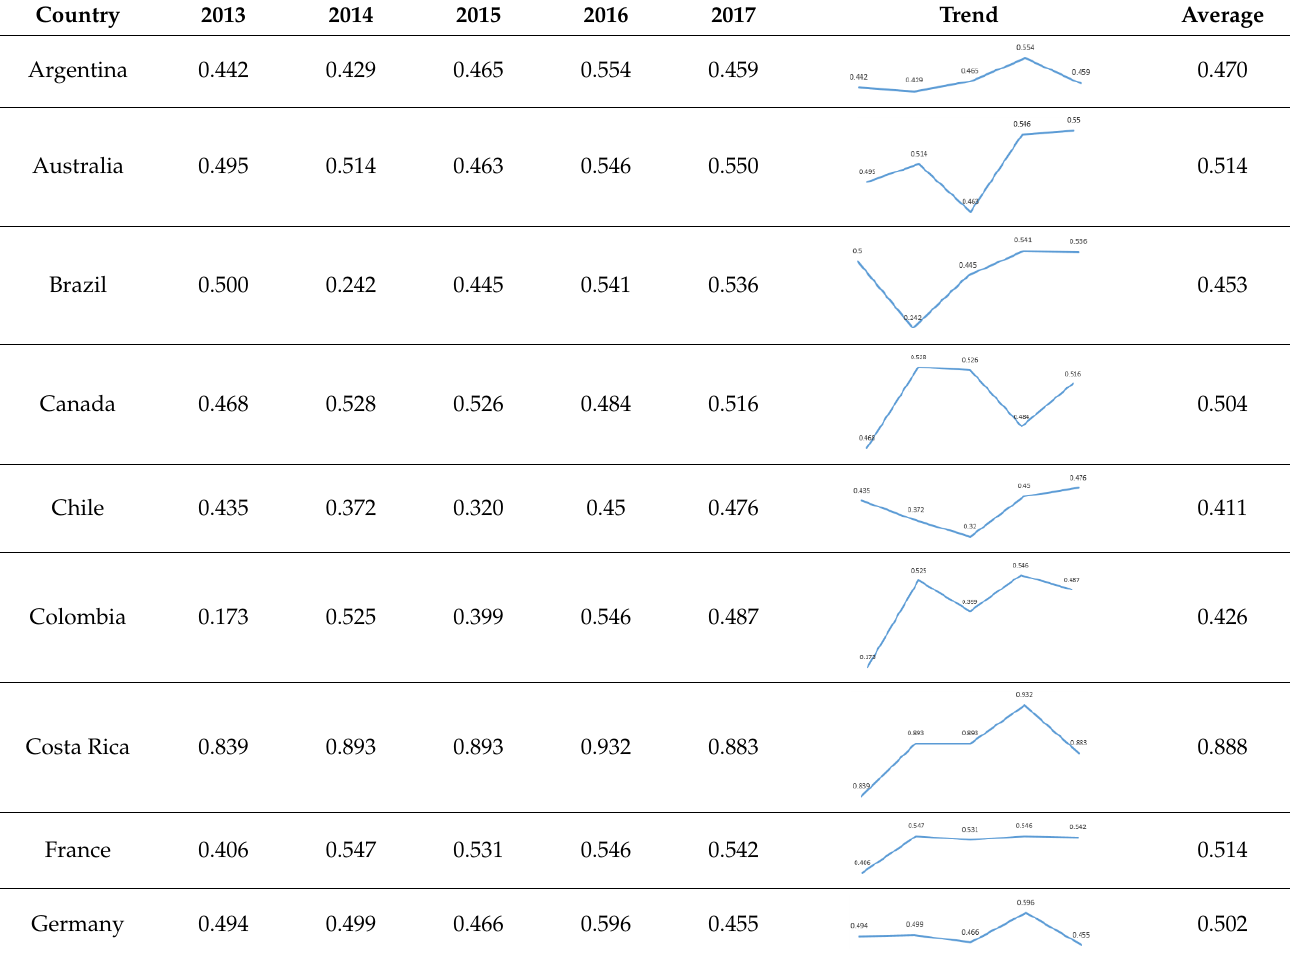
Figure 4. Structure of two-stage DEA. Figure 4. Structure of two-stage DEA. Table 5. Efficiency of two stages from 2013 to 2017. Table 6. Evaluation results of anti-corruption efficiency for each year. Table 6. Evaluation results of anti-corruption efficiency for each year. Table 6. Evaluation results of anti-corruption efficiency for each year. Table 6. Evaluation results of anti-corruption efficiency for each year. Table 6. Evaluation results of anti-corruption efficiency for each year. Table 6. Evaluation results of anti-corruption efficiency for each year. Table 6. Evaluation results of anti-corruption efficiency for each year. Table 6. Evaluation results of anti-corruption efficiency for each year. Table 6. Evaluation results of anti-corruption efficiency for each year. Table 6. Evaluation results of anti-corruption efficiency for each